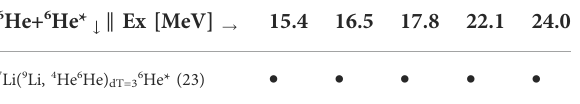
(cid:129) , indication of a peak with ◦ , and a possible